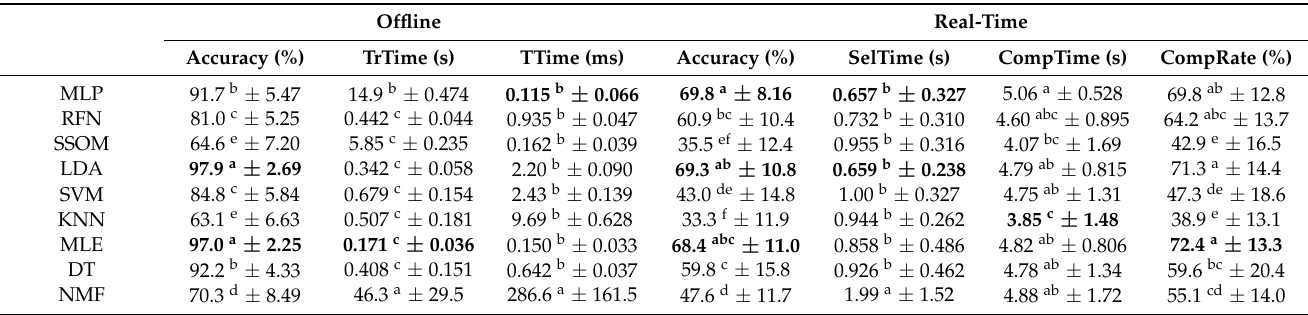
Table 1. Average and standard deviation of offline accuracy rate, training time (in seconds (s)), and testing time (in millisecond (ms)); real-time accuracy rate, selection time (s), completion time (s), and completion rate for all classifiers over 15 subjects. The best results in each column are